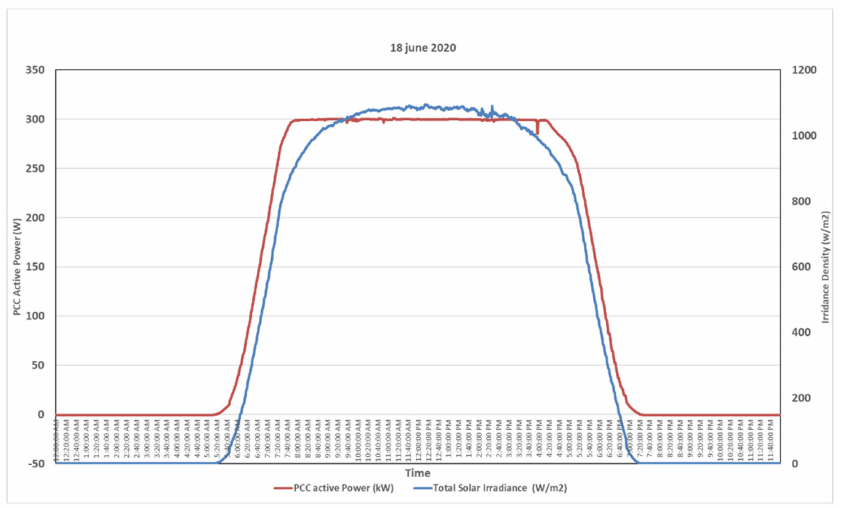
Figure 12. Power vs. irradiance on a sunny day.